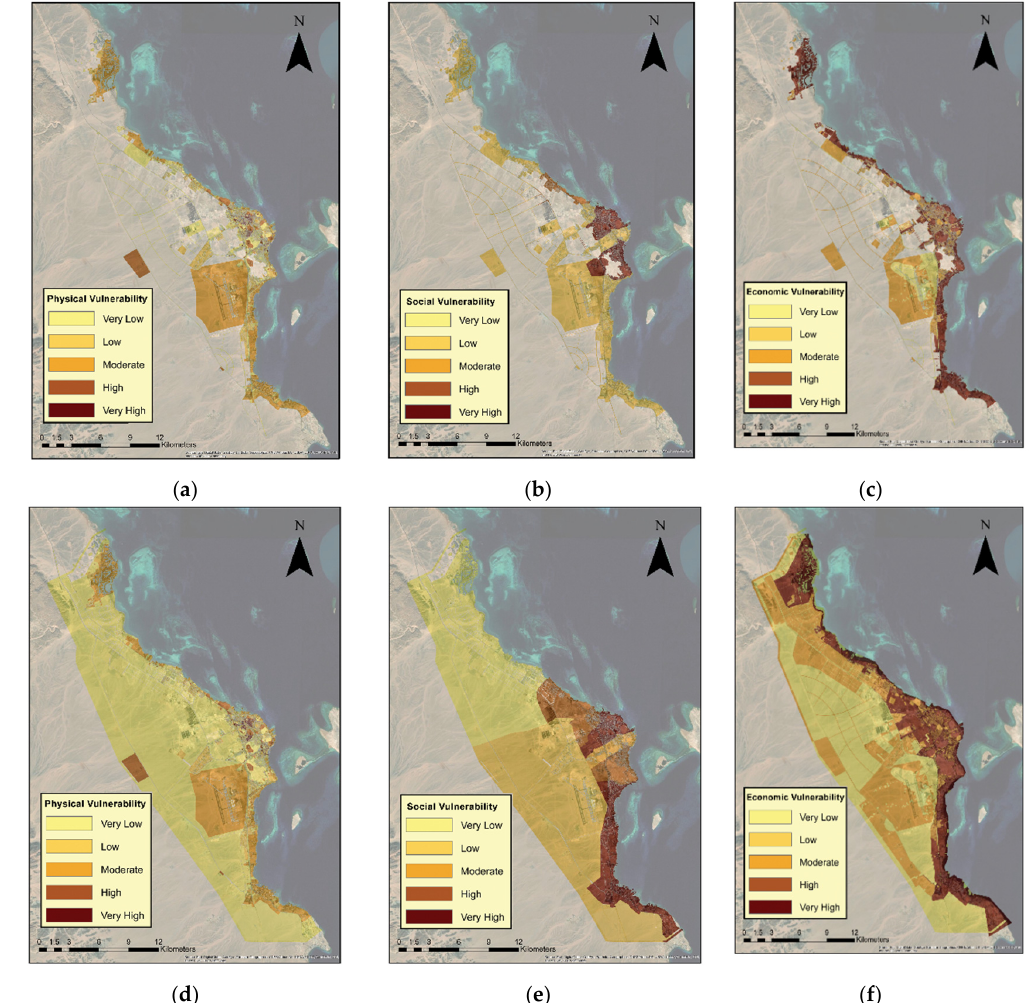
Figure 7. Physical, social, and economic vulnerability in the current situation ( a , b , c ) and in the future (2027) ( d , e , f ), respectively.